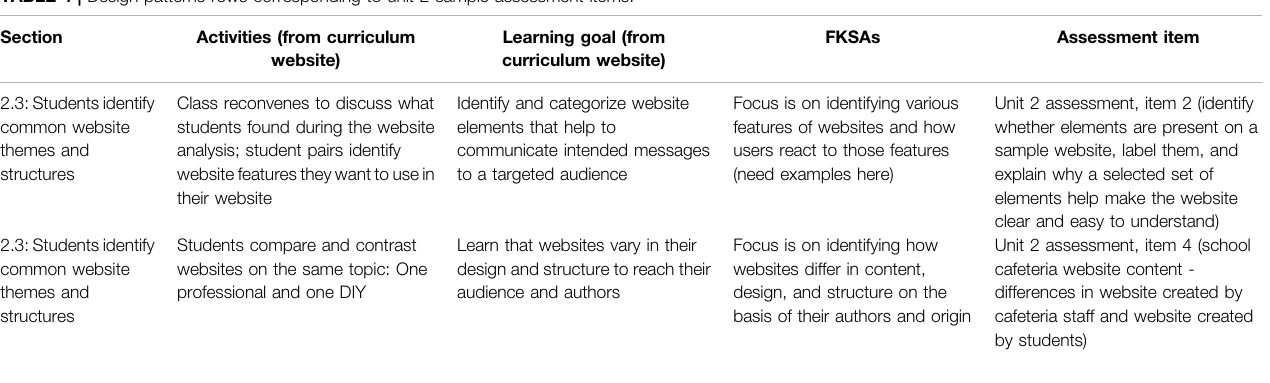
TABLE 4 | Design patterns rows corresponding to unit 2 sample assessment